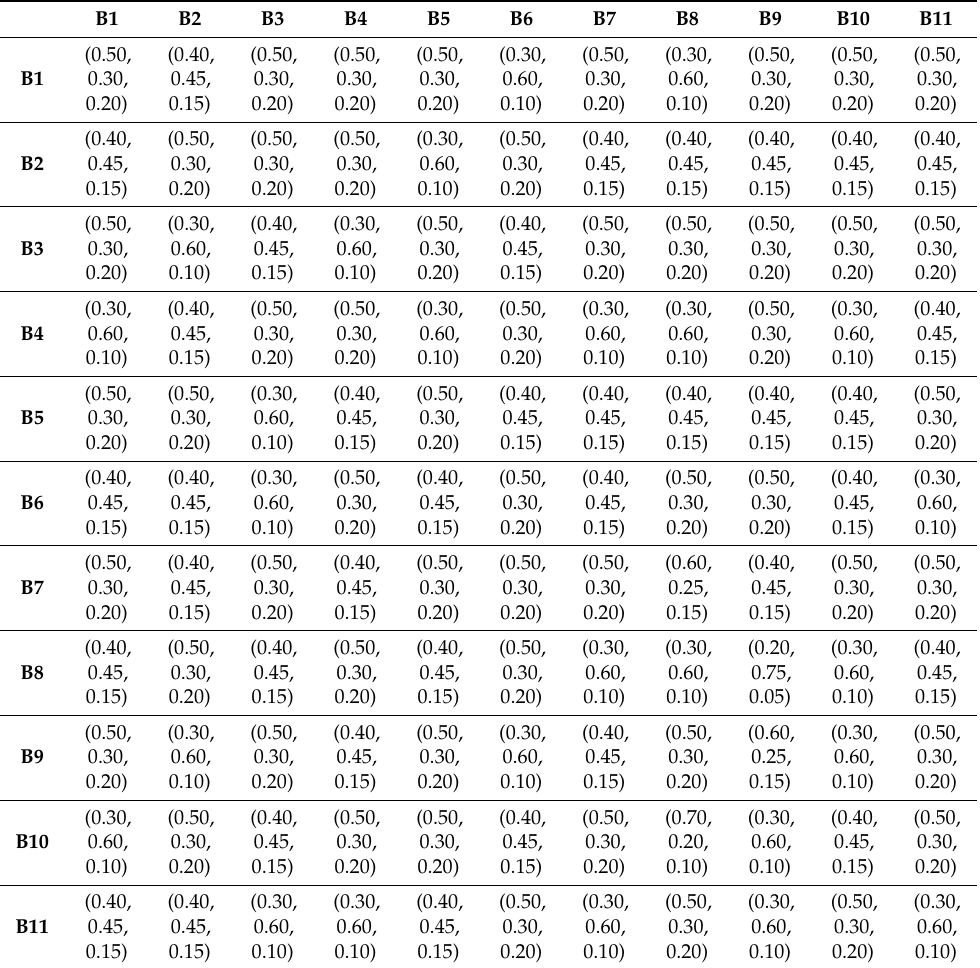
Table A2. Intuition fuzzy preference relationship of operational production indicators.